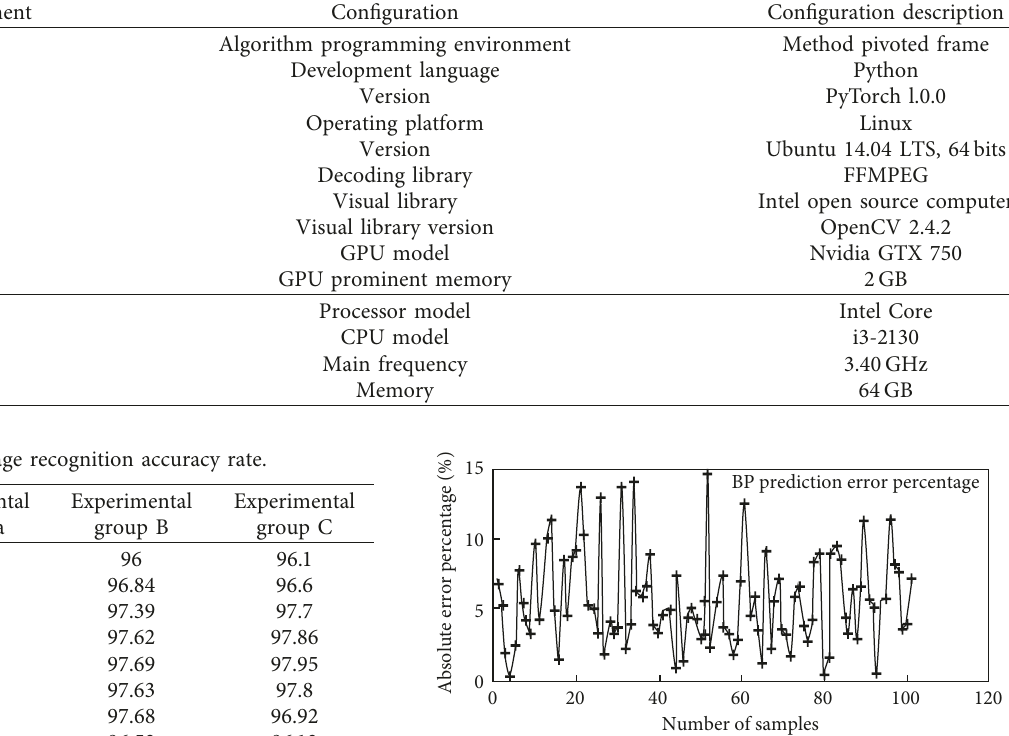
Figure 10: Neural network measurement